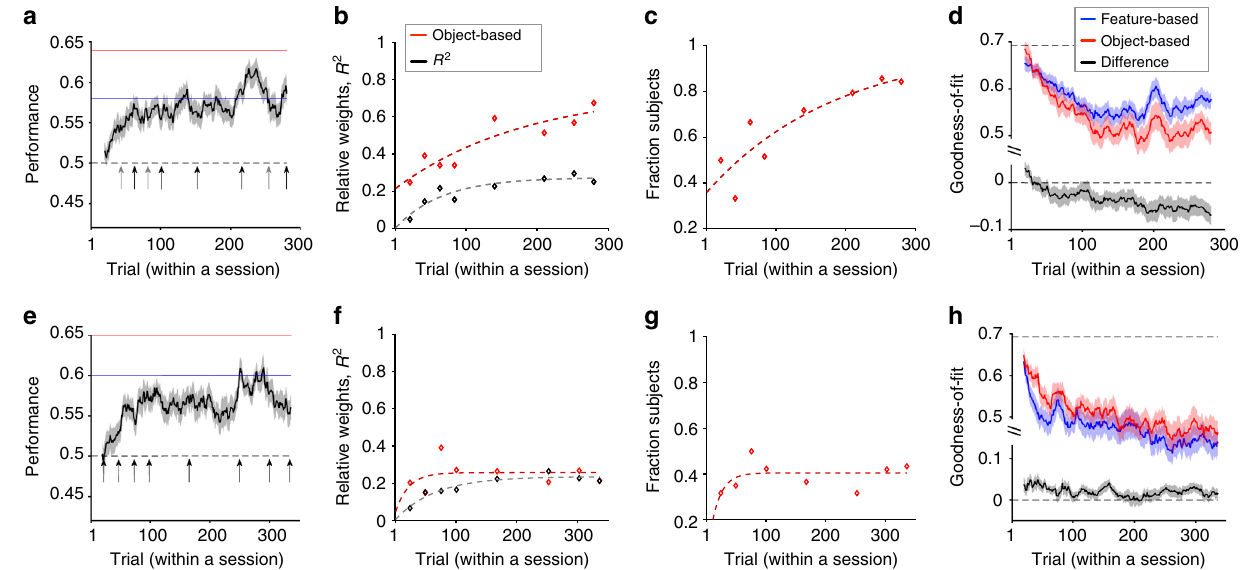
Fig. 3 Transition from feature-based to object-based learning in static, non-generalizable environments. a The time course of performance during Experiment 3. The running average over time is computed using a moving box with the length of 20 trials. Shaded areas indicate s.e.m., and the dashed line shows chance performance. The red and blue solid lines show the maximum performance using the feature-based and object-based approaches, respectively, assuming that the decision maker selects the more rewarding option based on a given approach in every trial. Arrows mark the locations of estimation blocks throughout a session. For some subjects, there were only fi ve estimation blocks indicated by black arrows. b The time course of model adoption measured by fi tting subjects ’ estimates of reward probabilities. Plotted is the relative weight of object-based to the sum of the object-based and feature-based approaches, and explained variance in estimates ( R 2 ) over time. Dotted lines show the fi t of data based on an exponential function. c Plotted is the fraction of subjects who showed a stronger correlation between their reward estimates and actual reward probabilities than the probabilities estimated using the reward values of features. The dotted line shows the fi t of data based on an exponential function. d Transition from feature-based to object-based learning revealed by the average goodness-of- fi t over time. Plotted are the average negative log likelihood based on the best feature-based model, best object-based RL model, and the difference between object-based and feature-based models during Experiment 3. Shaded areas indicate s.e.m., and the dashed line shows the measure for chance prediction. e – h The same as in a – d , but during Experiment